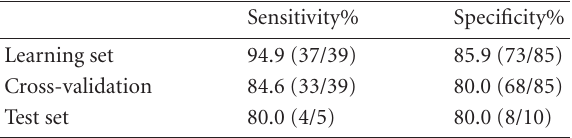
Table 3. Performance of the decision tree in predicting ovarian cancer. Numbers in parentheses denote the number of correctly classified sample out of total number of samples in the group.